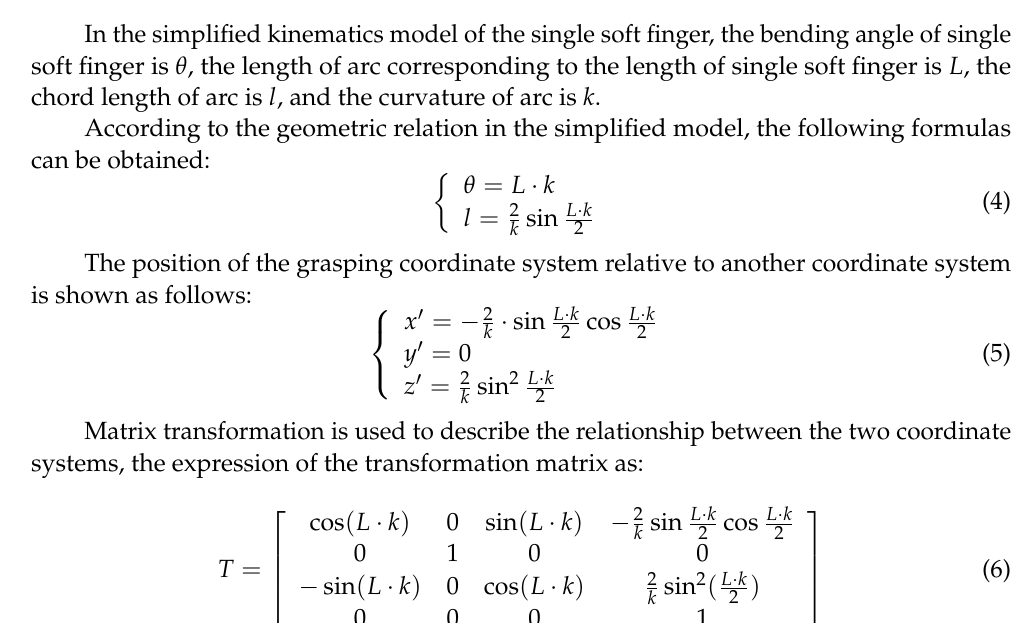
Figure 6. ( a ) Simplified kinematics model of single soft finger; ( b ) mechanical model of the grasped object; ( c ) grasping model of the grasped